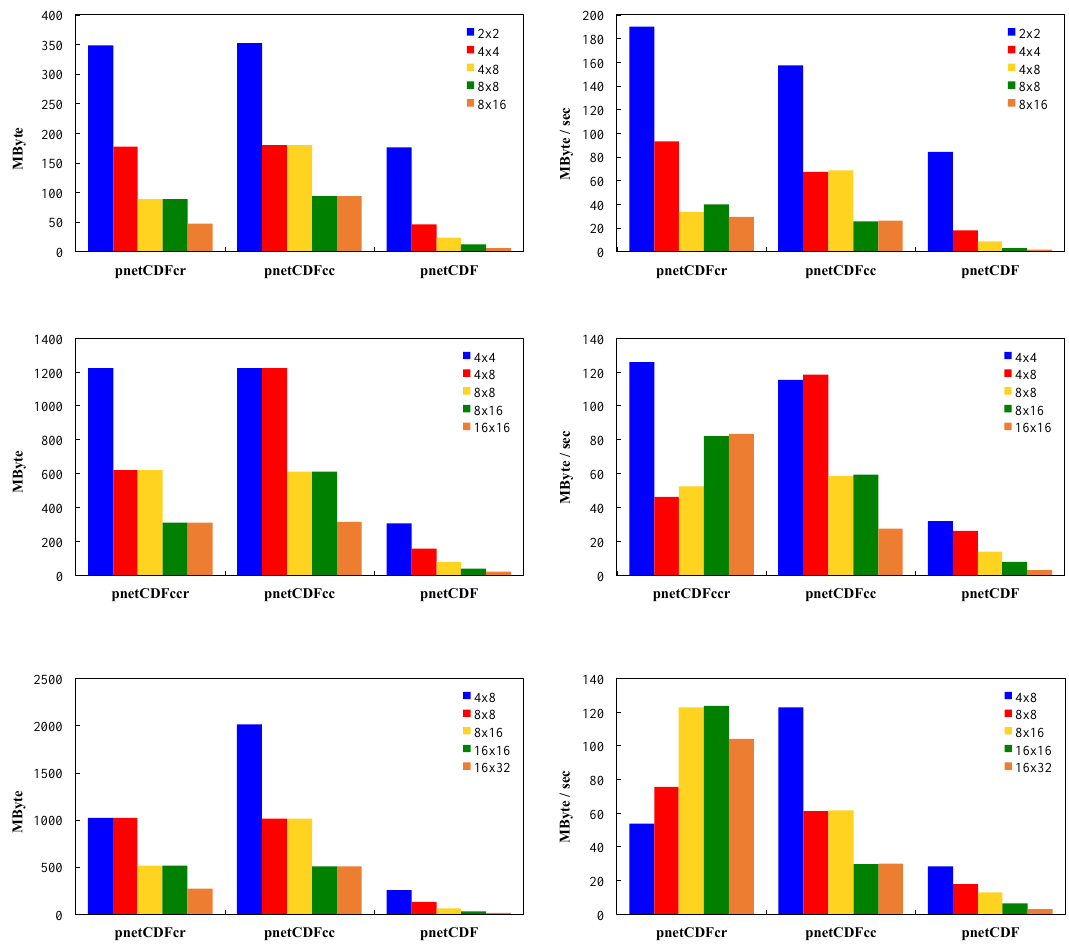
Figure 11. The maximum data size (left panel) and I/O rate (right panel) among all I/O processors in the CA (top), EUS (middle) and CONUS domains (bottom), respectively, in the pseudo-code experiment running on